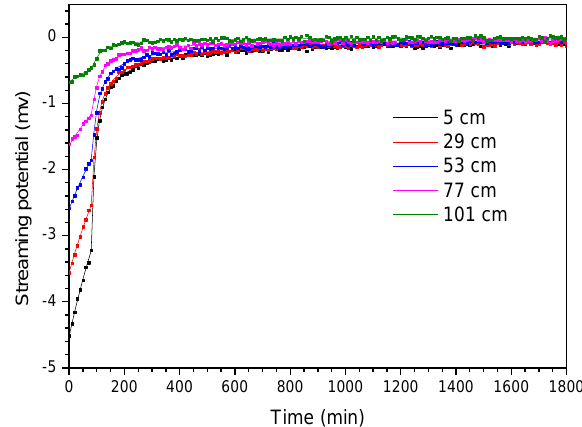
Figure 2. Reference SP signals. Solid lines represent the reference SP solution and dots represent the sets of perturbed data serving as conditioning information for model